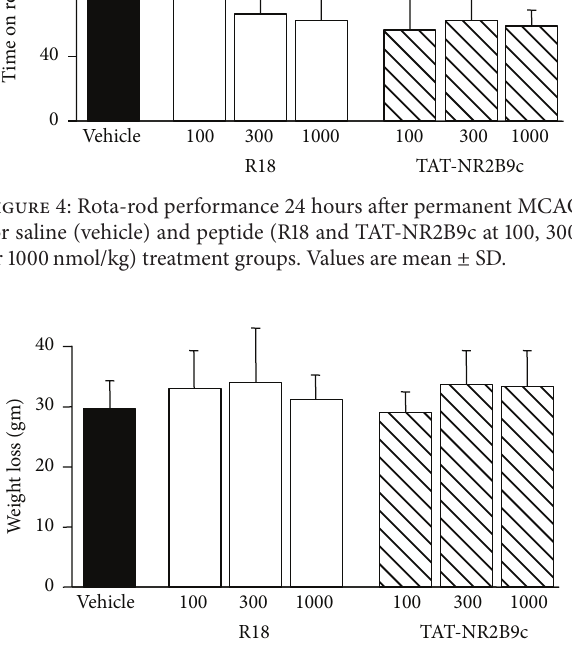
Figure 5: Weight loss at 24 hours after permanent MCAO for saline (vehicle) and peptide (R18 and TAT-NR2B9c at 100, 300, or 1000 nmol/kg) treatment groups. Values are mean ±